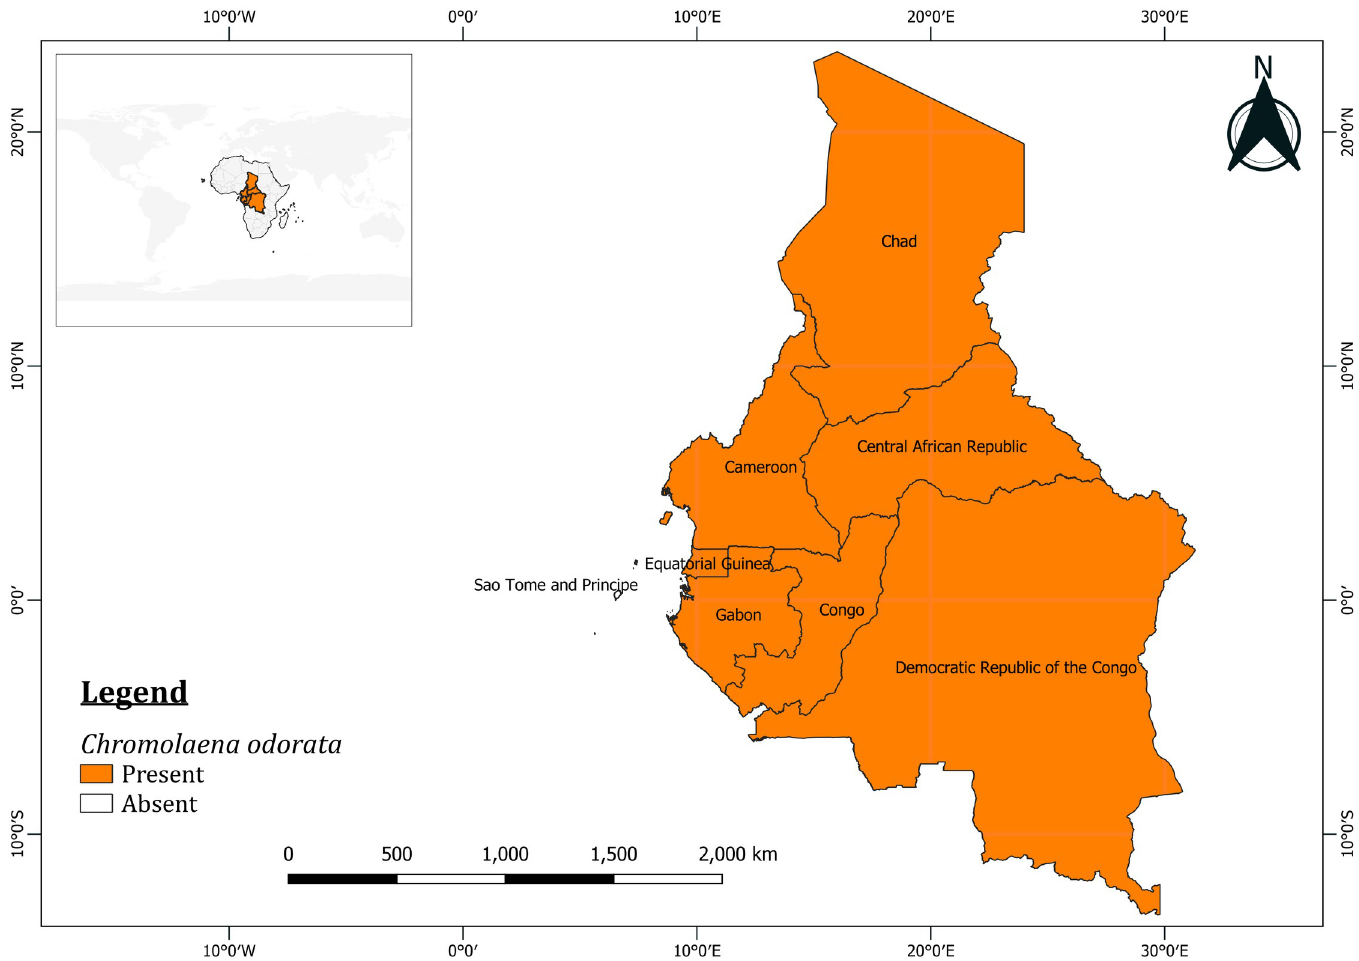
Fig 1. Occurrence and distribution of Chromolaena odorata in Central Africa. Only S ã o Tome´ and Prı´ncipe has no record of the plant in the region. This figure was generated in QGIS (version 3.16.1 Hannover) https://qgis.org/downloads/ and the source files were obtained from Natural Earth https://www.naturalearthdata.com/.